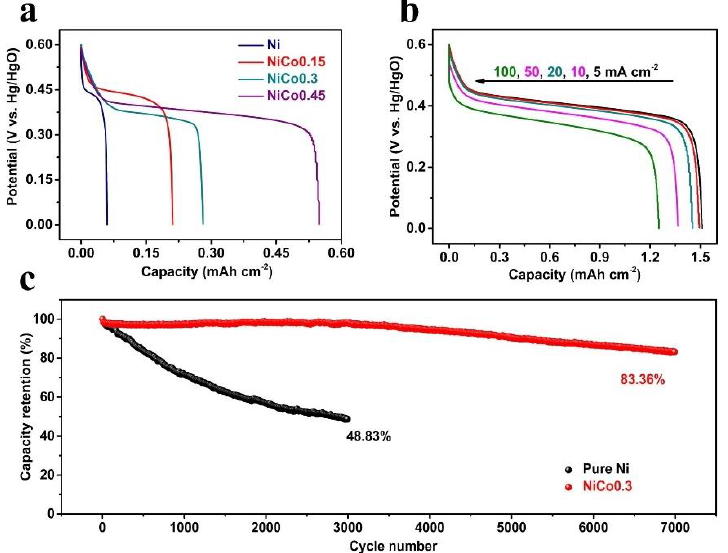
Figure 3. Discharge curves of ( a ) four microelectrodes at the current density of 10 mA cm −2 and ( b ) the NiCo0.3 microelectrode under various current densities. ( c ) The cycling performance of pure Ni and NiCo0.3 microelectrodes.